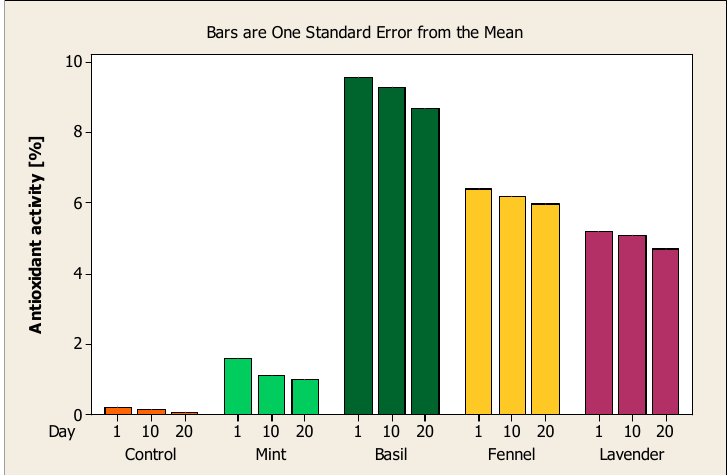
Figure 6. The average antioxidant activity of the yoghurt samples on the first day, the 10th day and the 20th day of analysis.